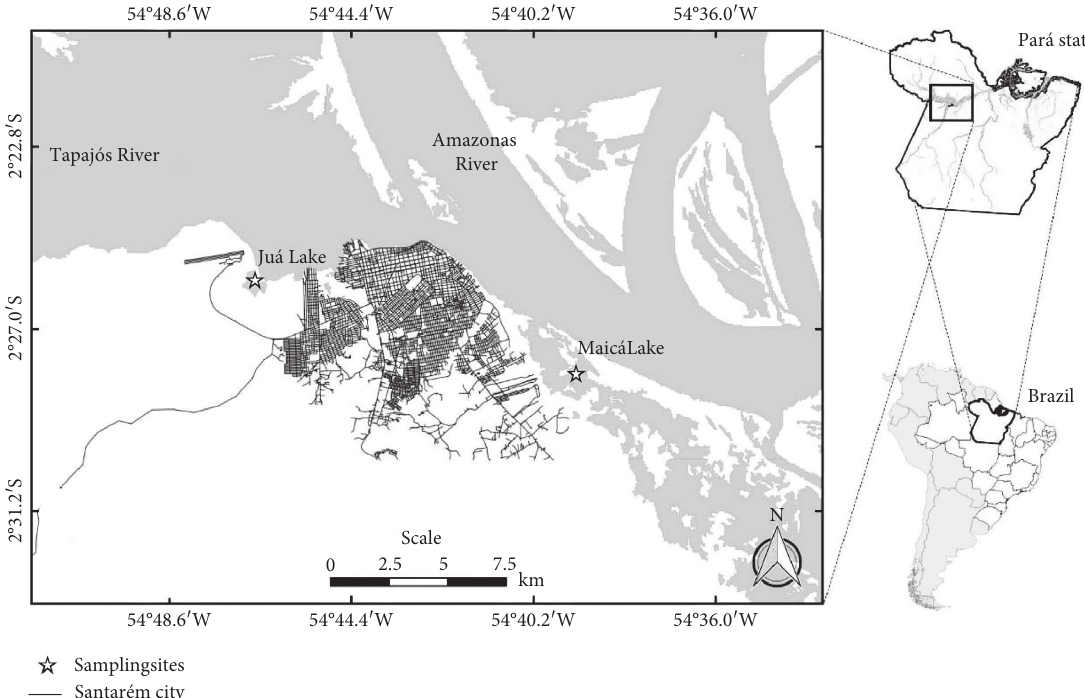
Figure 1: Map of the location of the Lakes Ju´a and Maic´a belonging to the basin of the lower Tapaj´os River, Santar´em, Par´a, Brazil (source: Lima, J.